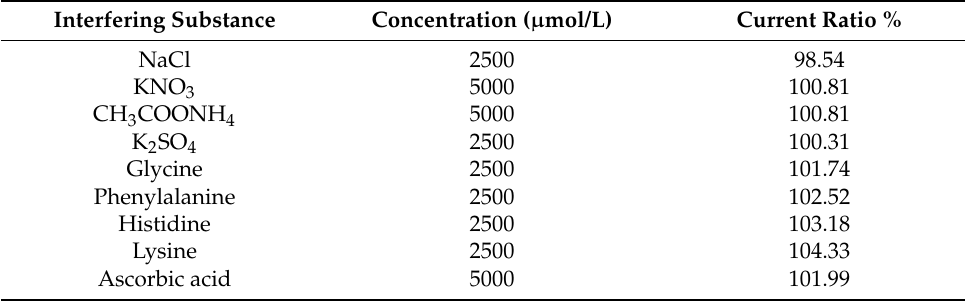
Table 2. Interference of different substances on the determination of